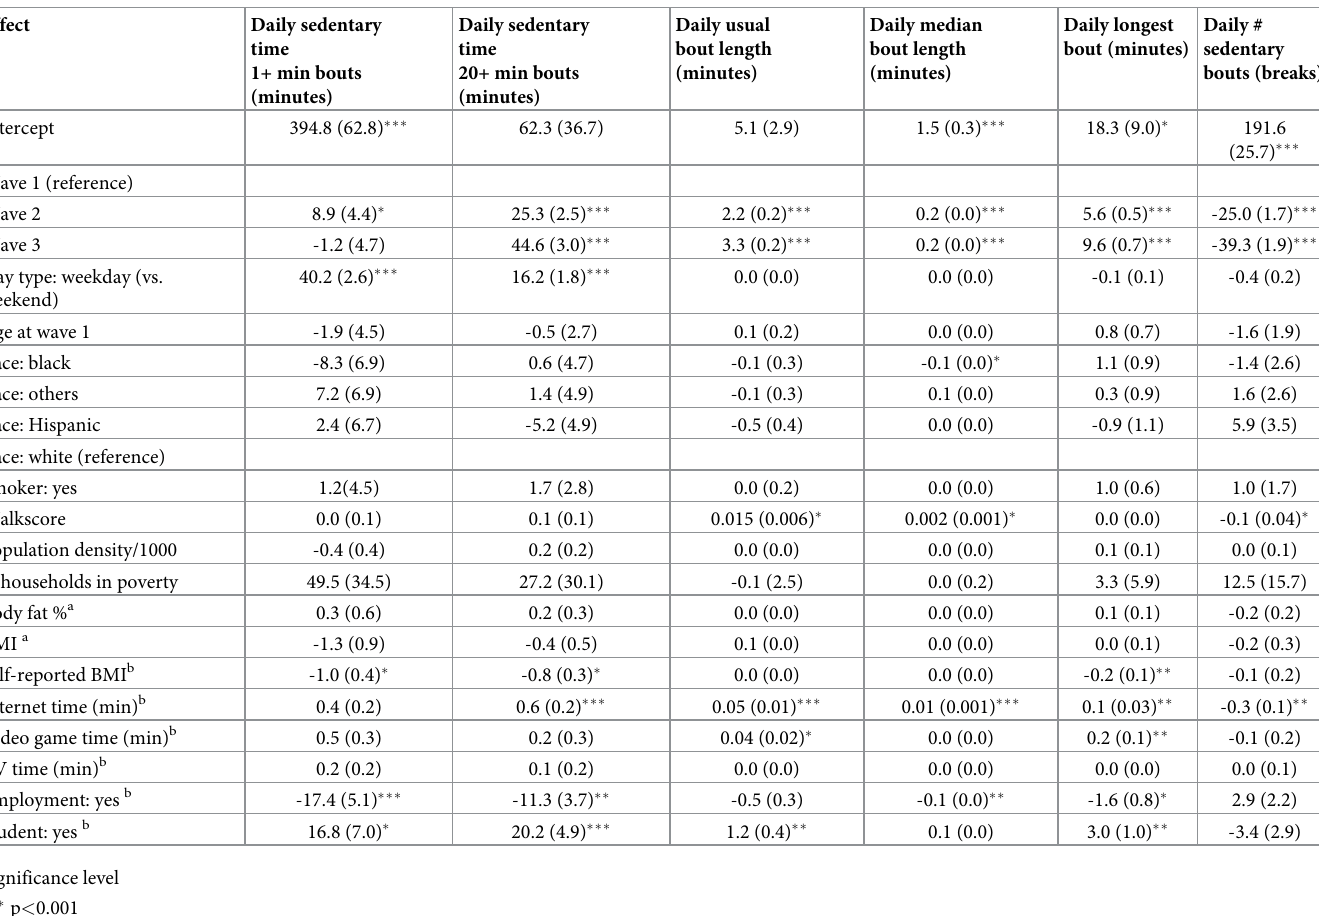
Table 2. Models estimating associations with sedentary behavior patterns (standard